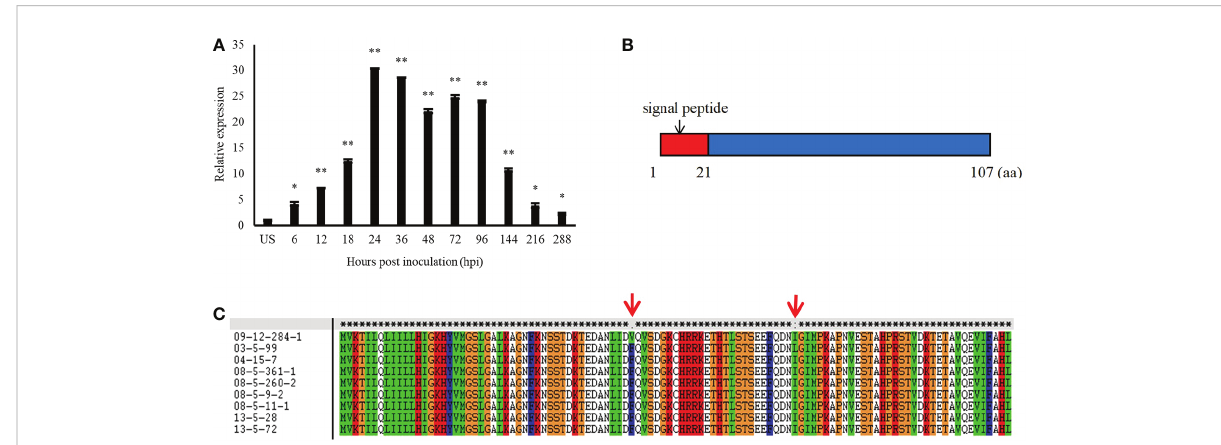
FIGURE 1 The expression pattern and structure of Pt13024 during the infection of wheat by P . (A) Transcript levels of Pt13024 at various stages of Pt infection. The relative gene quanti fi cation was calculated by the comparative Ct method, with the Pt -endogenous gene EF1 as an internal standard and was relative to that of US. Three technical replicates and biological repetition for each treatment were analyzed. Means and SE from three independent replicates are shown. Asterisks indicate signi fi cant differences (** p < 0.01, * p < 0.05). (B) The primary structure of Pt13024. (C) There were two polymorphic sites of the Pt13024 gene-encoding protein among nine different Pt isolates. The red arrow represents the location of the mutation site. US, urediniospores; Pt, Puccinia triticina ; SP, signal